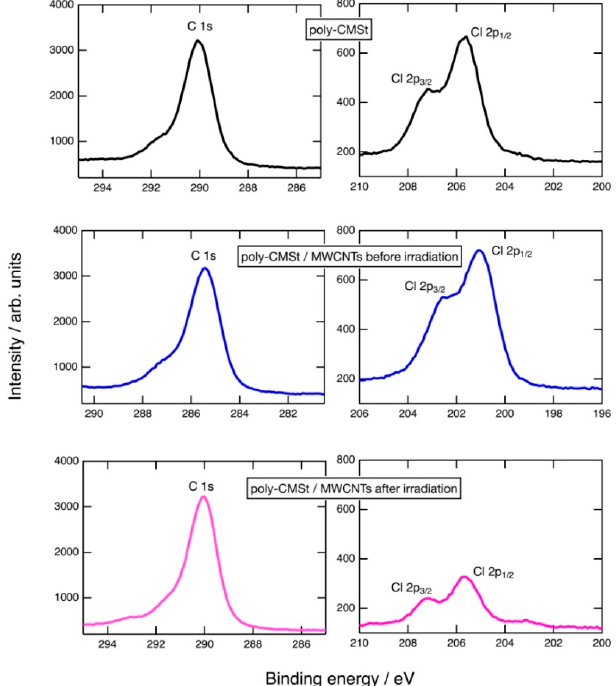
Figure 2. C 1s and Cl 2p X-ray photoelectron spectra observed for intact poly(p-chloromethyl)styrene (poly-CMSt) and for poly-CMSt/multi-walled carbon nanotube mixture before and after ultraviolet irradiation.